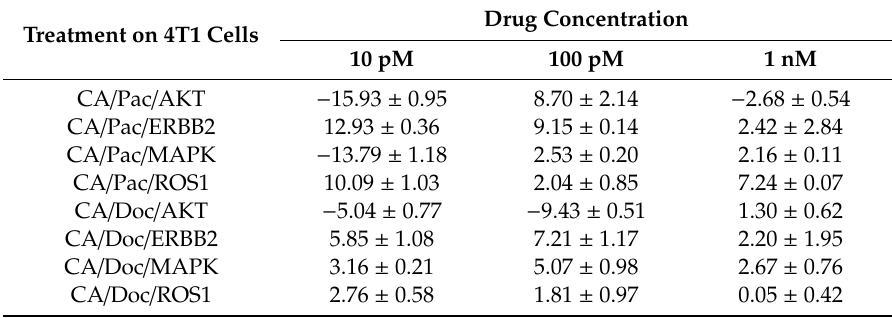
Table 6. E ff ect of silencing various pathways on cytotoxicity of classical anti-cancer drugs in 4T1 cells. Data is presented as mean ± SD compared to CA /